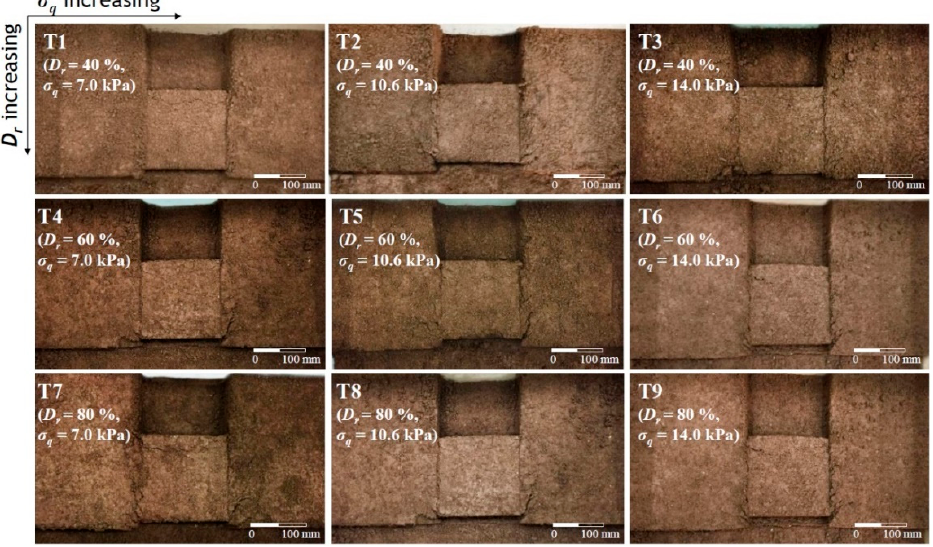
Figure 7. Shape of the failure surface after the model track experiments (top-view).